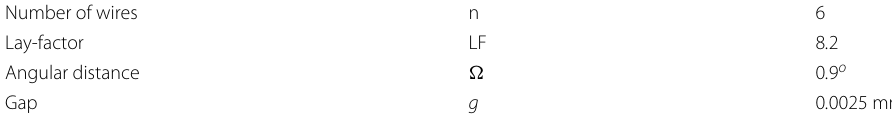
Table3 Constant geometrical parameters of the reference strand